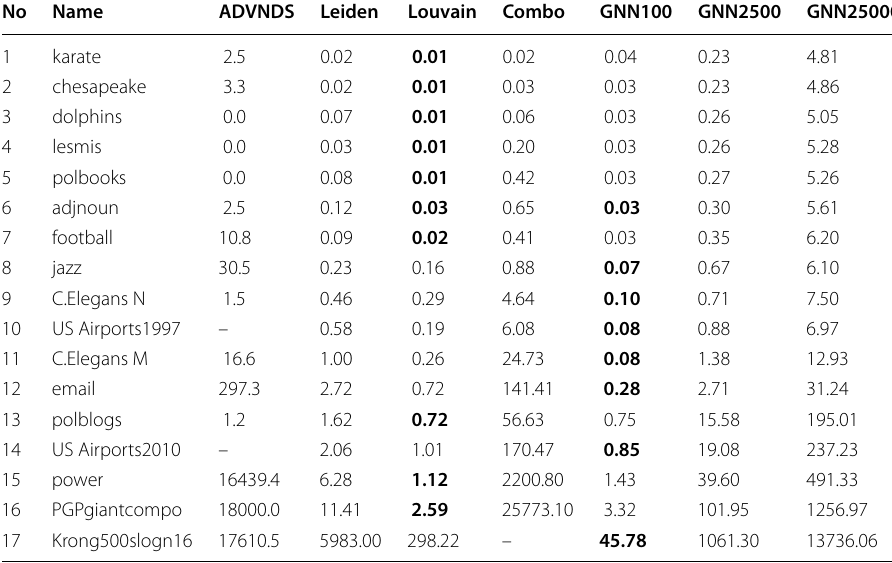
Table 3 Execution time (in seconds) of the ADVNDS, Leiden, Louvain, Combo, and GNNS algorithms over the classic network examples